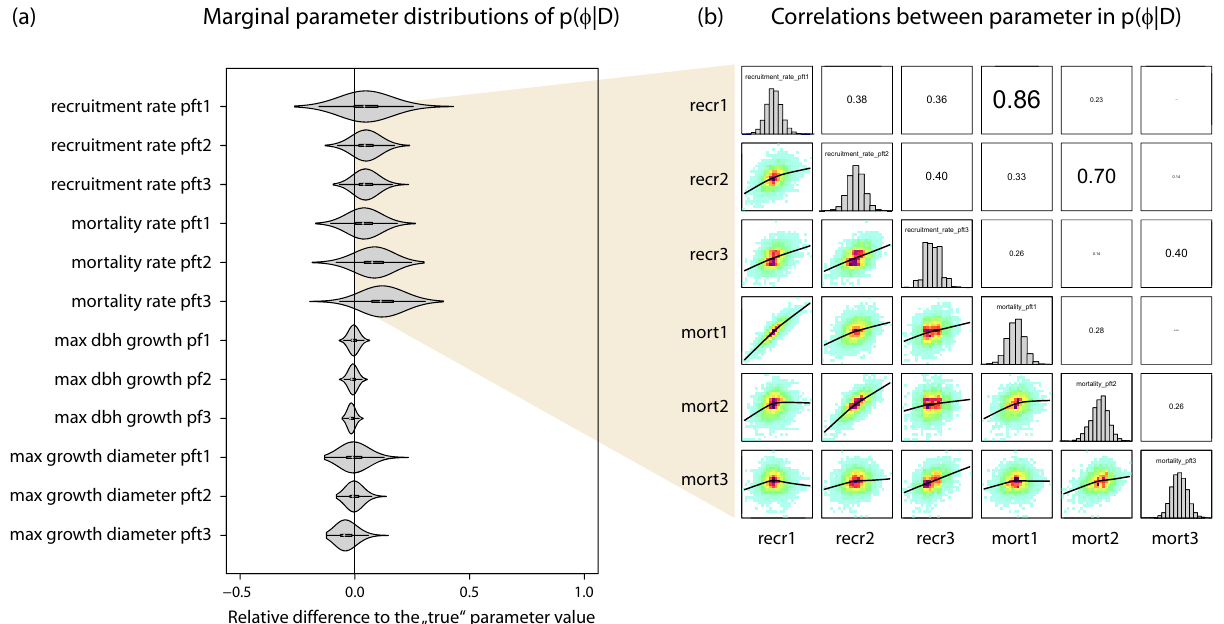
Fig. 3. Summaries of the estimated parameter values (shown as probability distributions) after fitting the model to the virtual inventory data (case V1 in Table 2). The distributions in (a) correspond to the marginal posterior density p(φ | D) for each parameter, scaled relative to the “true” values that were used to create the synthetic data (see Table 2 in the Supplement for true values and units). The dot within each distribution denotes the median value. Panels in (b) visualize correlations between recruitment and mortality parameters in the posterior sample (recr1 refers to the recruitment rate of PFT1, mort2 refers to mortality of PFT2 and so on). The diagonal shows the marginal distributions displayed in panel (a) . The lower triangle shows the correlation density between the parameters on the diagonal (red values denoting higher density) and a nonlinear fit of the correlation (black line). The upper triangle shows Spearman’s rank correlation coefficients for the correlations in the lower